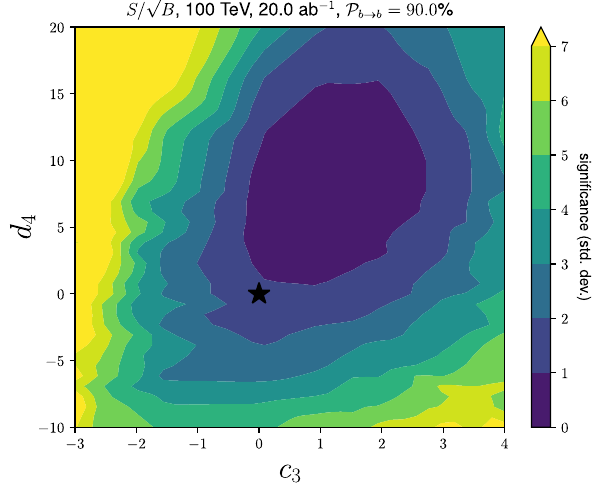
( λ 4 = λ SM ( 1 + d 4 ) and λ 3 = λ SM ( 1 + c 3 ) ) at the FCC-hh at 100 TeV.